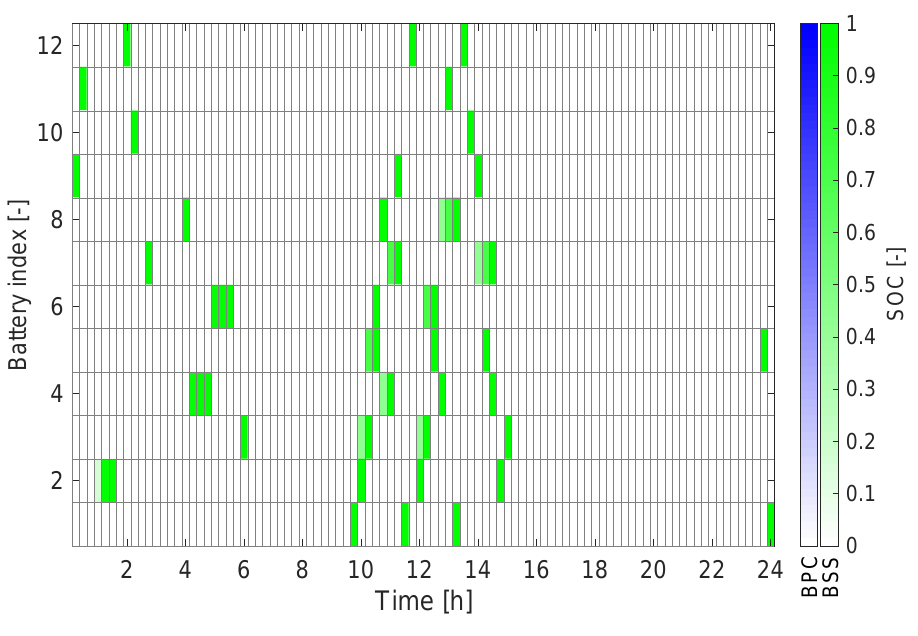
Figure 7. Battery state of charge time evolution at LIMB for the case of the Most Demanding Day